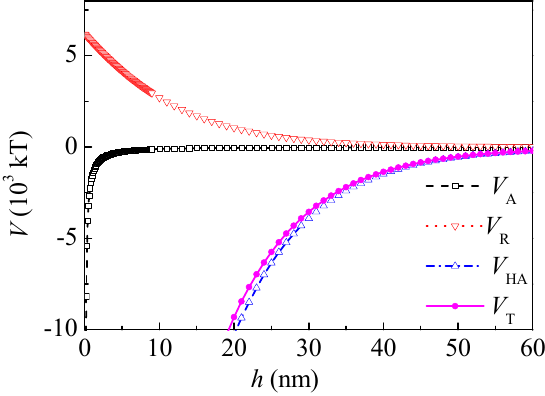
Figure 4. Potential energy between coal particles after adsorption of polyacrylamide A401 (PAM A401).